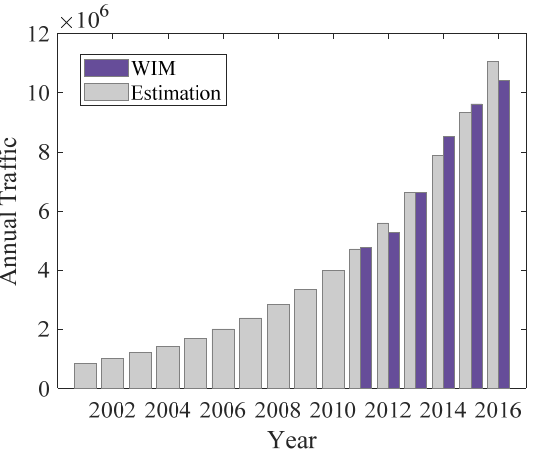
Figure 5. Comparison of monitoring and estimated annual average traffic volume.